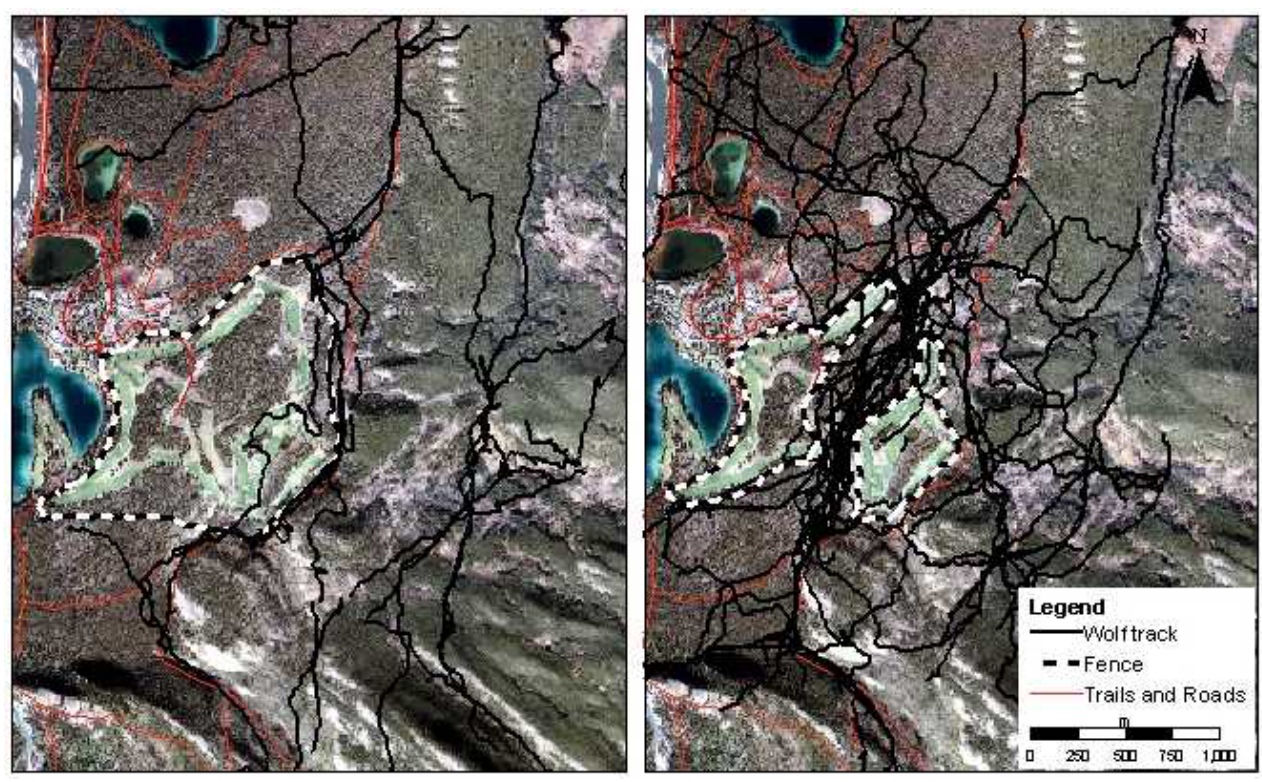
Fig. 3. Wolf paths through the study area one winter prior to (left) and two winters following (right) corridor